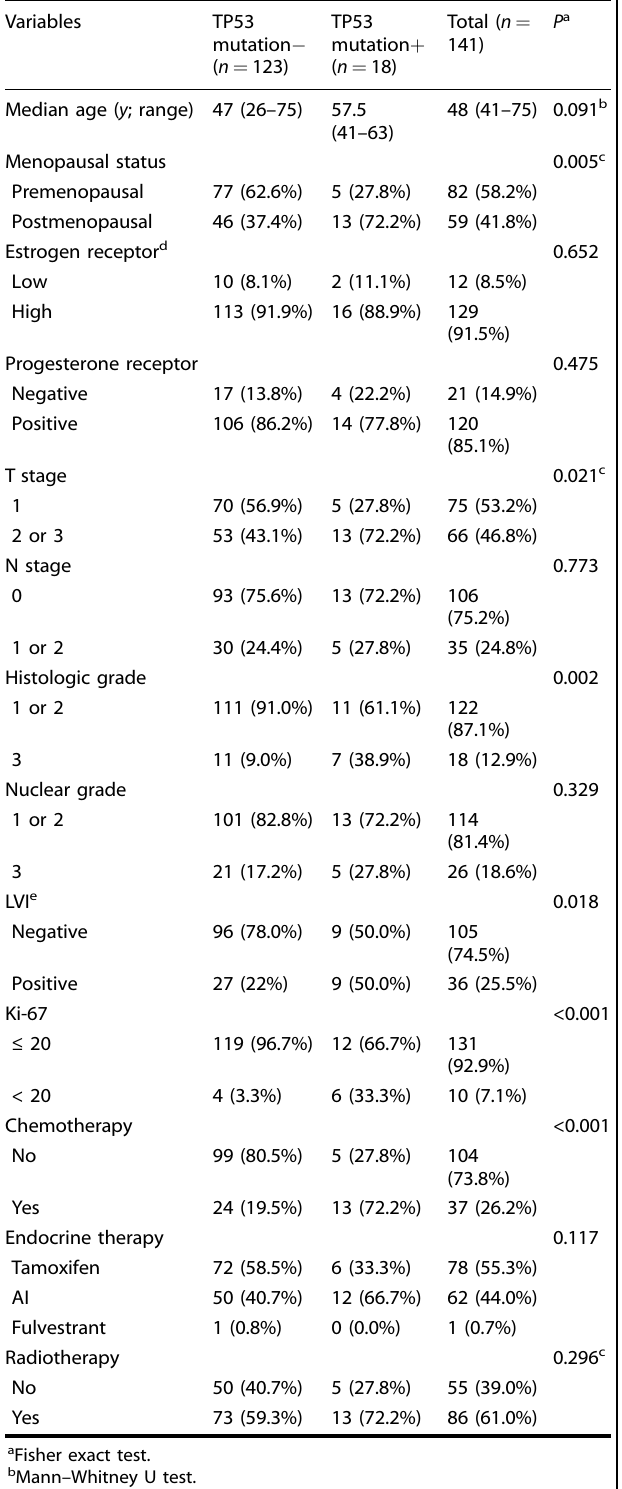
Table 1. Baseline patient characteristics and